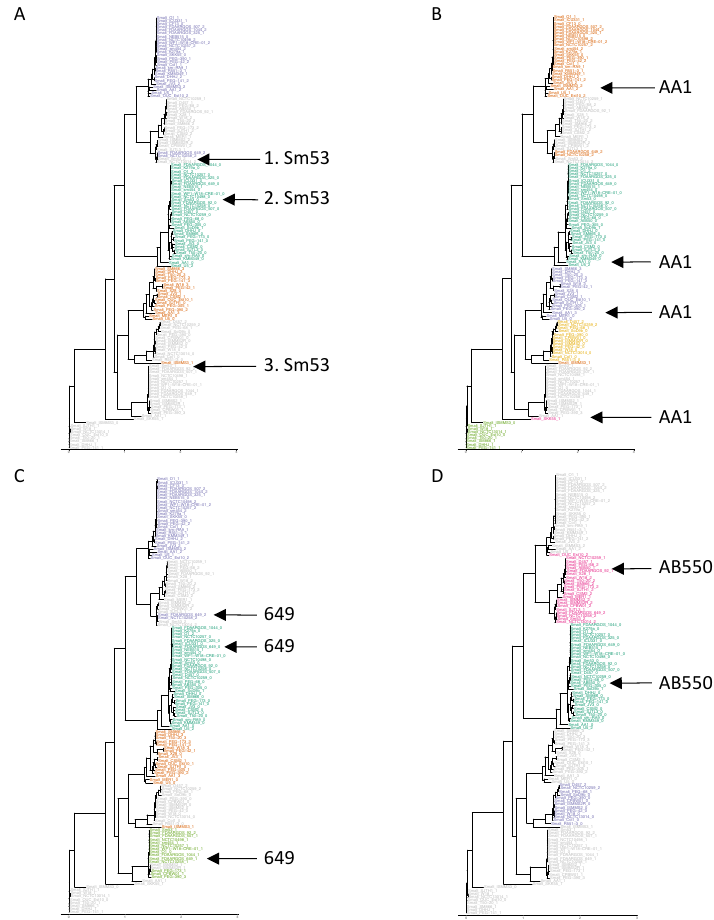
Figure 3 - Phylogenetic trees built from RAYT genes extracted from S. maltophilia genomes. RAYT genes are coloured by RAREFAN according to their association with REPIN populations in the reference genome. If a REPIN population of a query genome is not present in the reference genome, then the REPIN population cannot be identified in the query genome and the corresponding RAYT gene cannot be linked and is coloured in grey. The four panels A-D show phylogenies for four different reference strains. S. maltophilia strains Sm53, AA1, 649 and AB550 were used in panels A to D , respectively. Locations of a reference strain's RAYT genes in the tree are indicated by arrows. An association between almost all RAYTs and REPIN populations could be made by using four different reference genomes. Most of the RAYT genes are coloured (associated with a REPIN group) in at least one of the trees. The three numbered RAYT genes from the Sm53 RAREFAN run are referenced in the